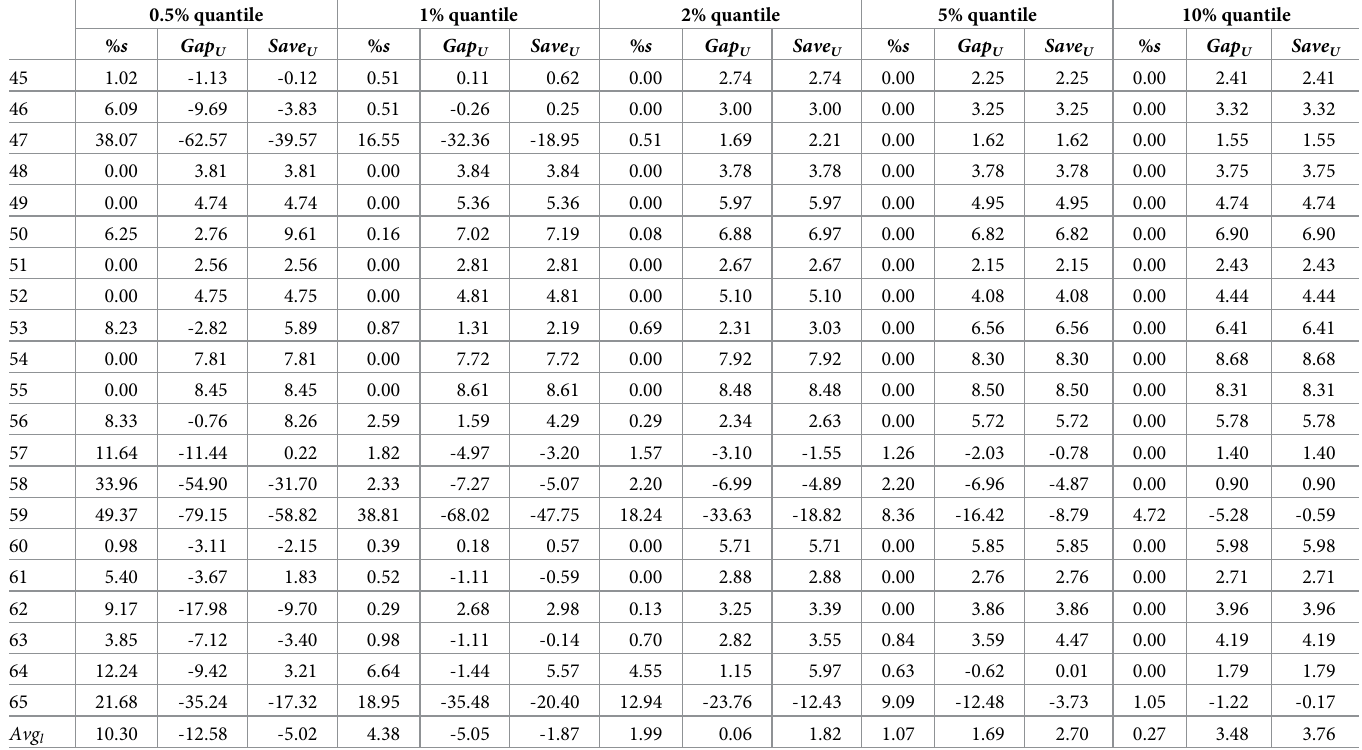
Table 6. Computational results for large-size instances with different values of λ